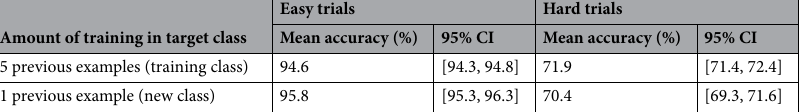
Amount of training in target class